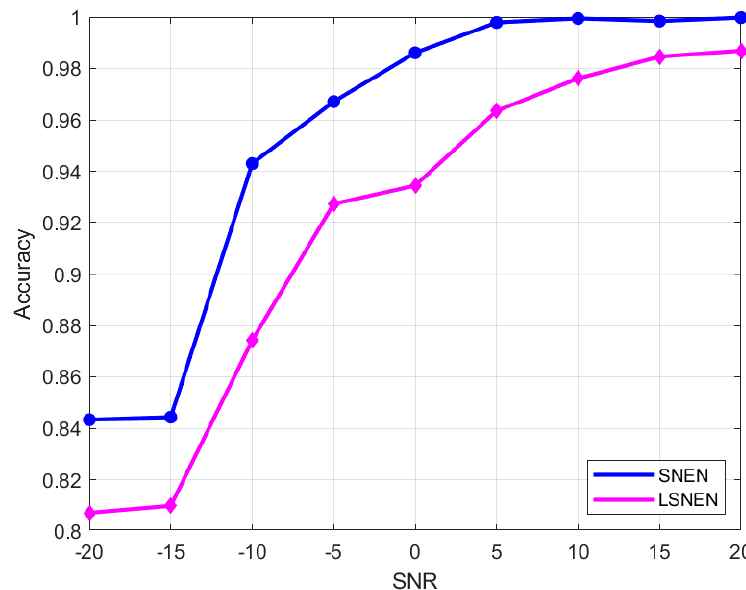
Figure 8. Comparison chart of accuracy before and after pruning.